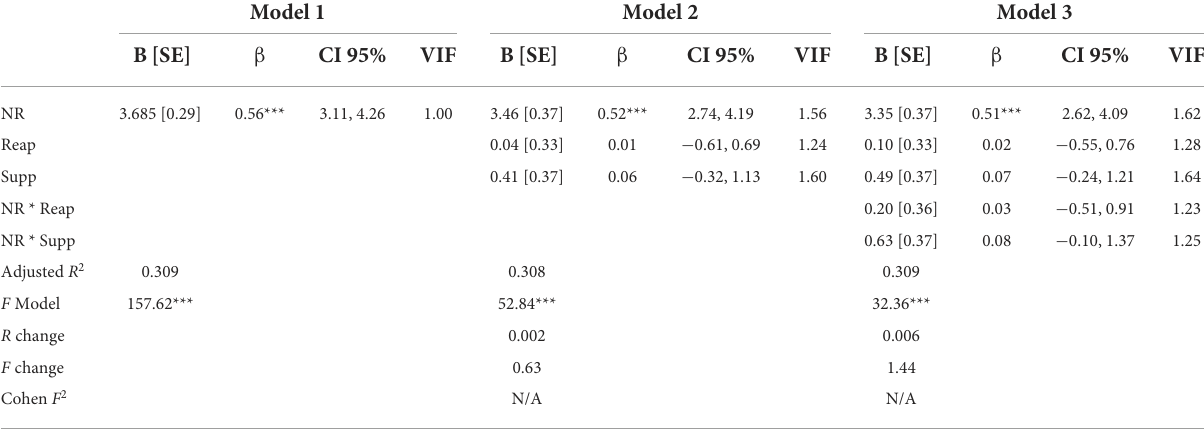
TABLE 3 Moderation model estimates for the association between negative rumination and insomnia